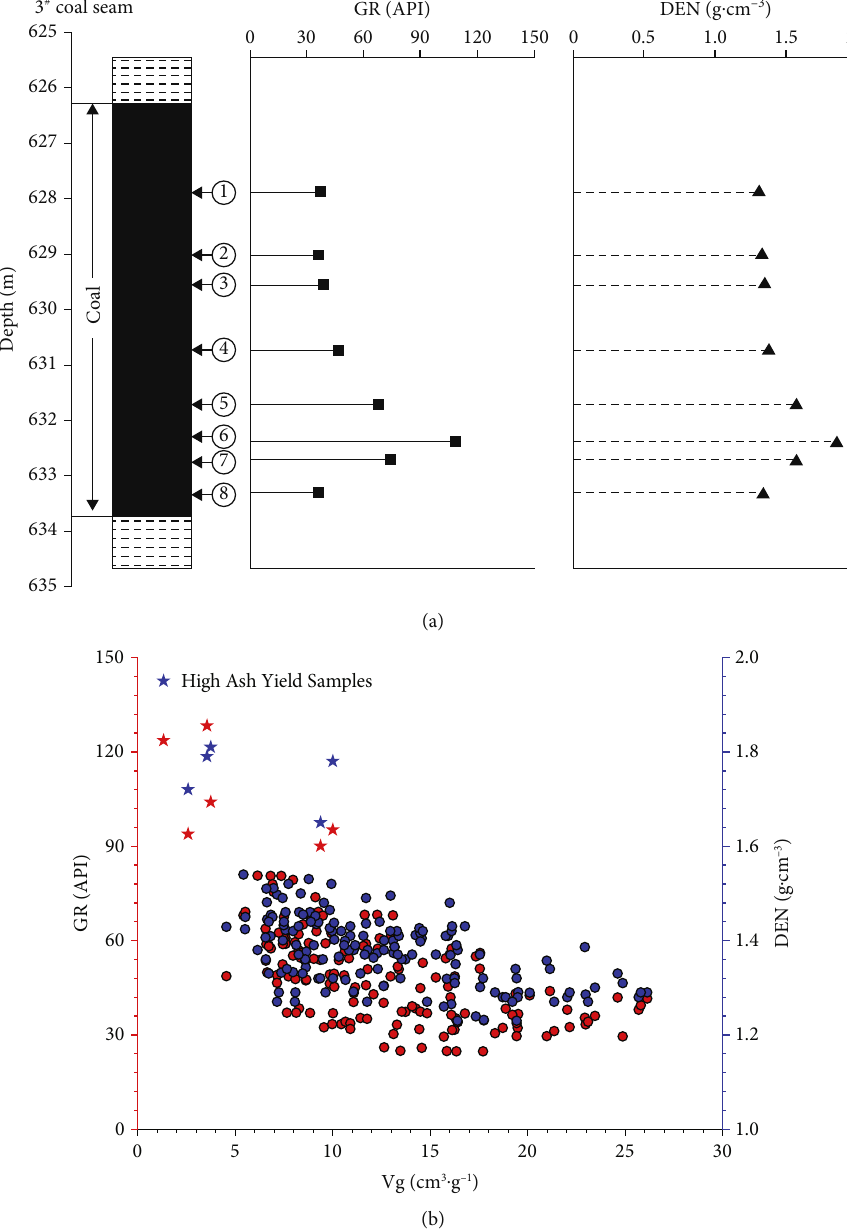
Figure 4: Rejection of core samples from the gangue section: (a) logging response trend of the sample at the gangue; (b) analysis of the di ff erence between the logging response of anomalies on the rendezvous